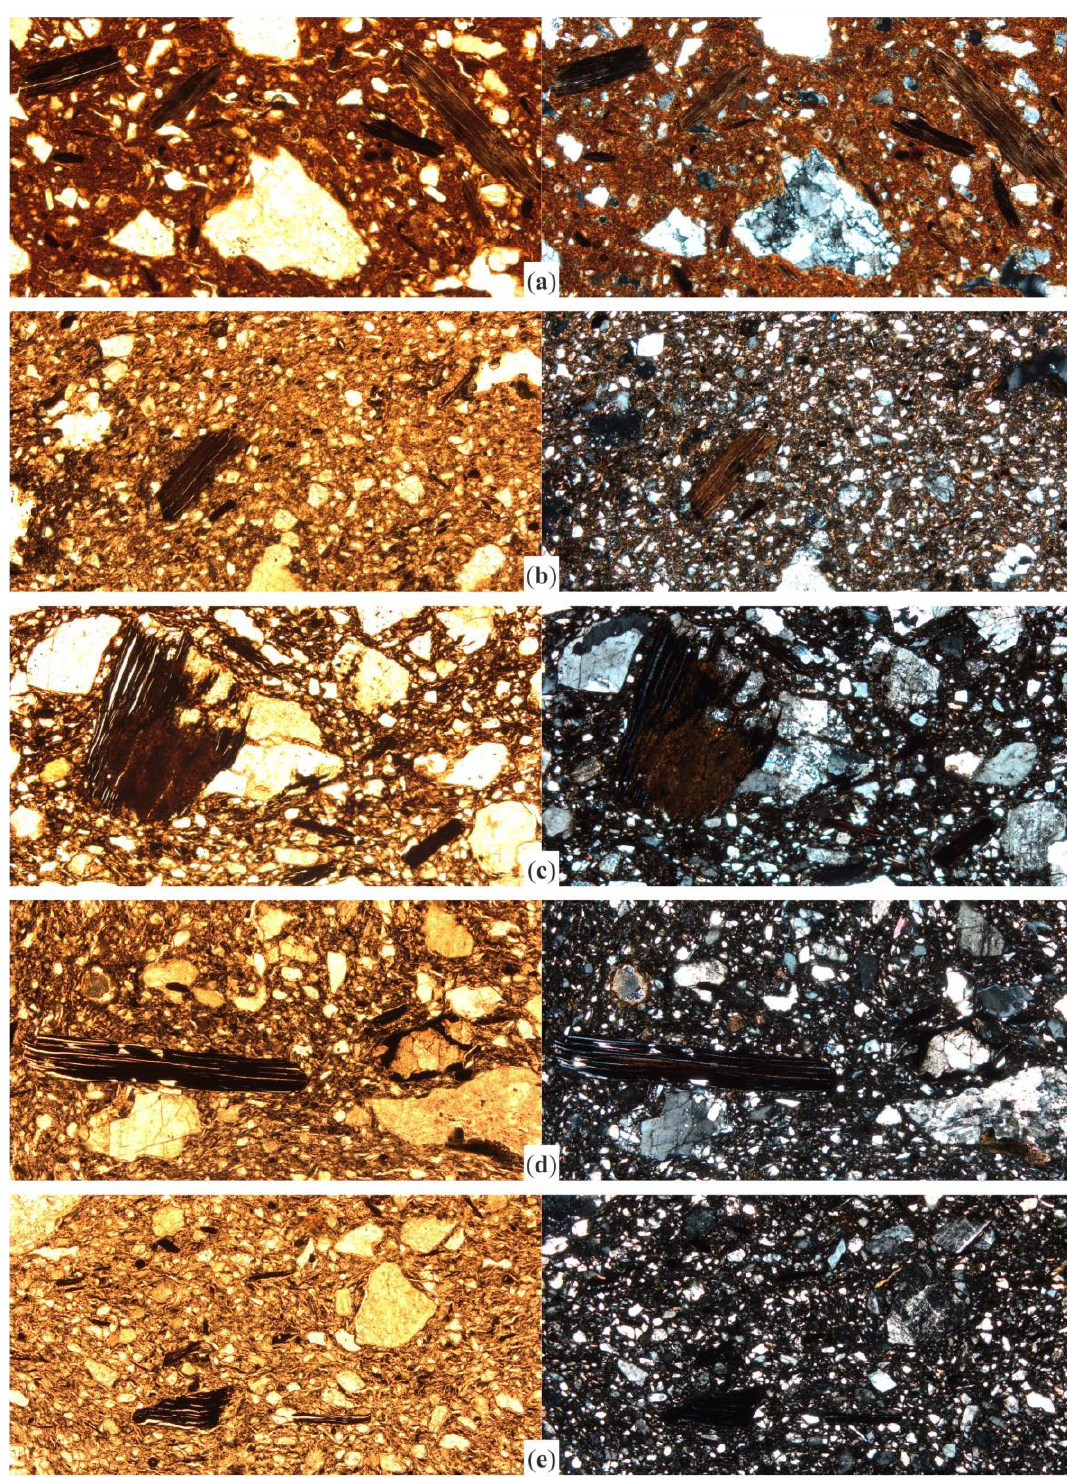
Figure B1. Photomicrographs of selected samples from Cabrera d’Anoia. Sample CA017 ( a ) was fired at <750 °C and shows strong pleochroism and normal cleavage in most inclusions. Sample CA031, fired at <850 °C still includes pleochroic inclusions but laths start separating ( b ). At 900–950 °C and above, cleavage is open or very open according to temperature increase, as shown in sample CA104 ( c ), still with weak pleochroism, and CA090 ( d ) with non-pleochroic dark brown inclusions. Above 950 °C, biotite inclusions are usually black under reducing atmosphere, with very open cleavage. All the images were captured in plane polarized light (left column) and crossed polars (right column), at 40× magnification. Image width = 3 mm.